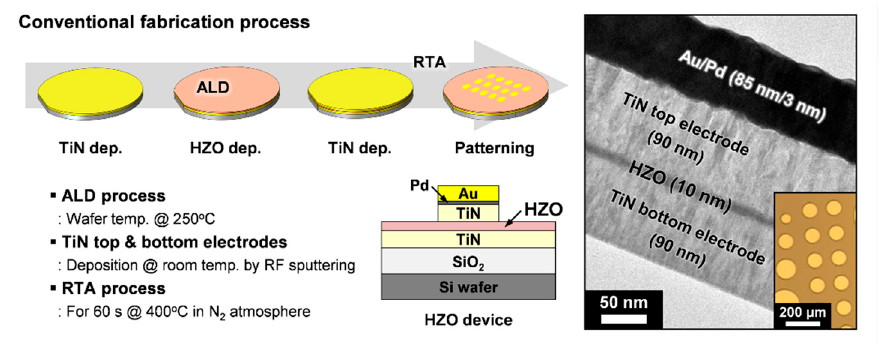
Figure 1. A schematic illustration of the conventional procedure used to fabricate MIM capacitors and cross-sectional transmission electron microscopy and optical microscopy images of the fabricated TiN/HZO/TiN capacitors.